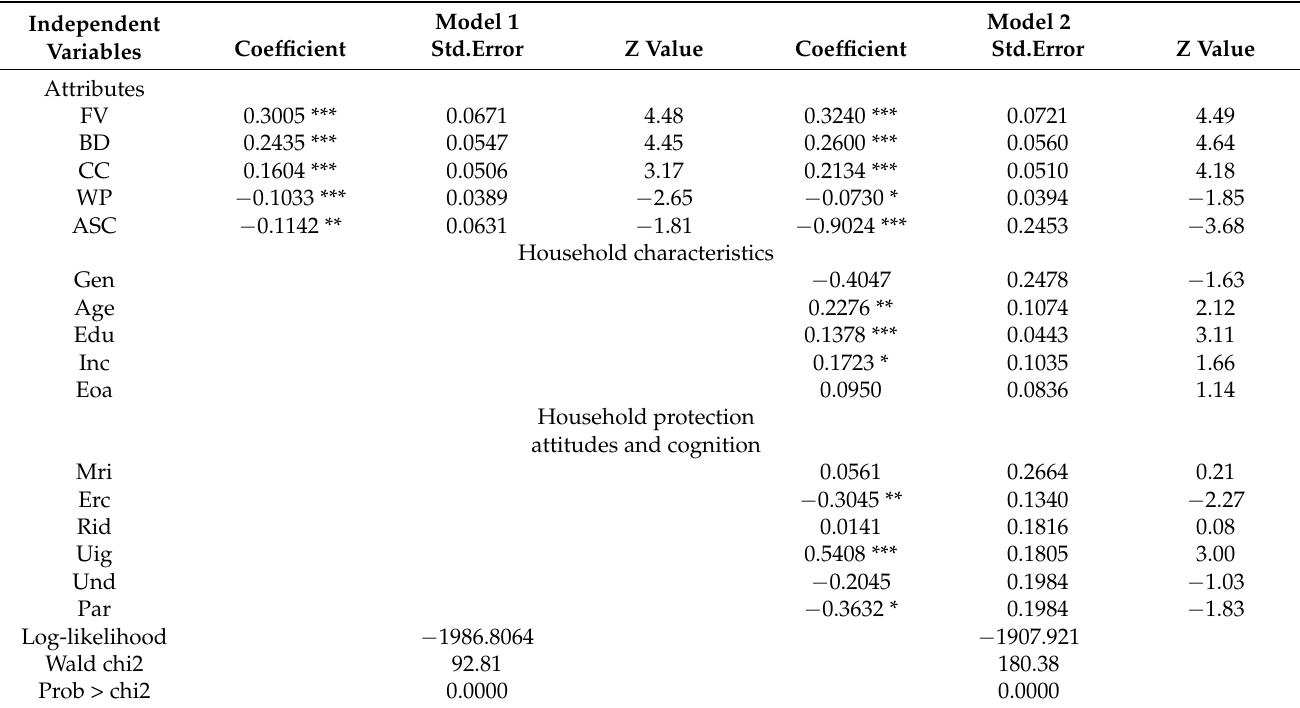
Table 3. Estimation results from mixed logit